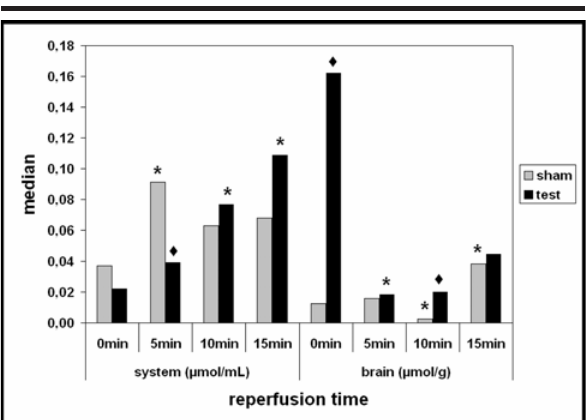
FIGURE 2 - Systemic and brain beta-hydroxybutyrate (BHB) concentrations in sham and test groups at different times of reperfusion. [ ♦ ] p<0.05 compared with respective sham group; [ * ] p<0.05 compared with similar previous group (Mann-Whitney U test)